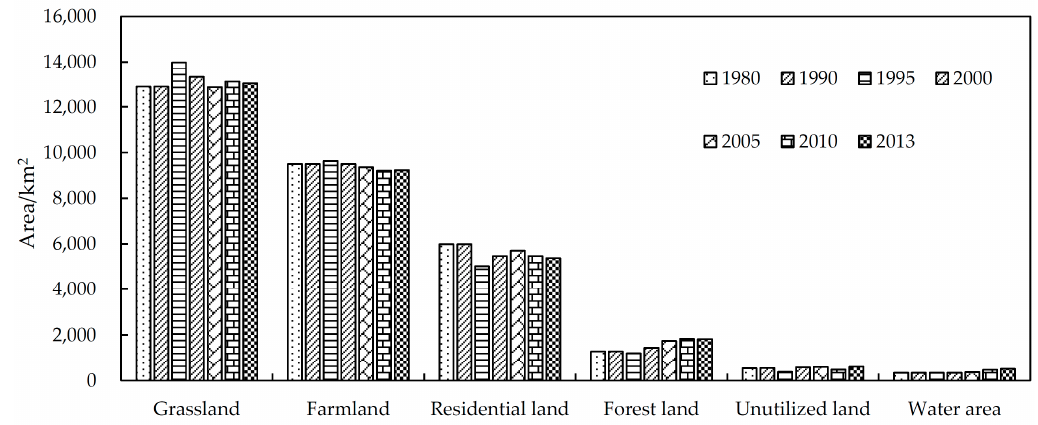
Figure 9. Land use in the Wuding River Basin.